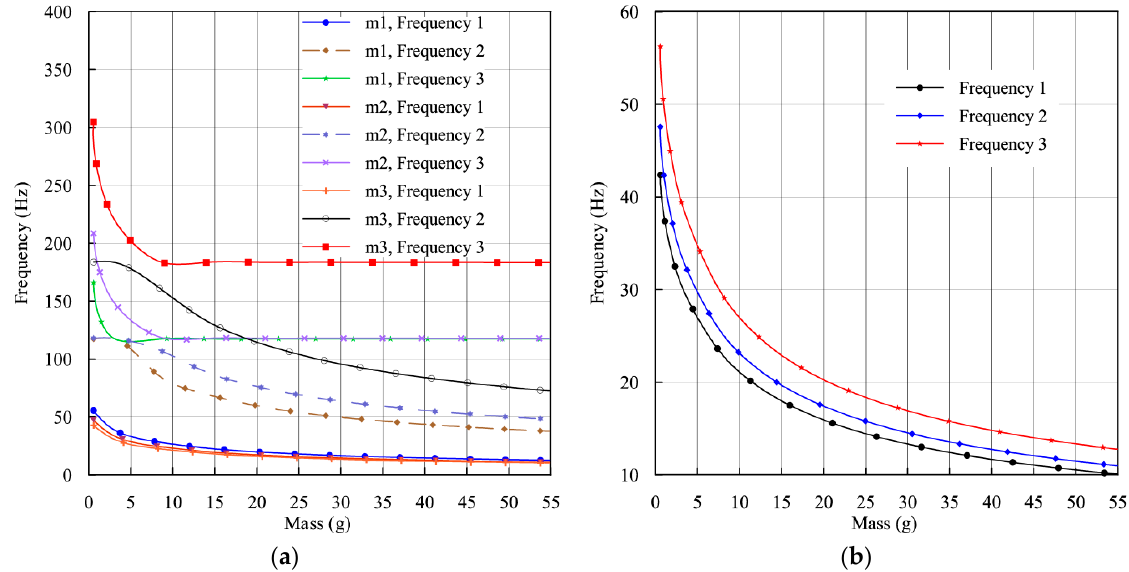
Figure 2. Effect of mass on natural frequency: ( a ) variation with individual masses and ( b ) variation with total